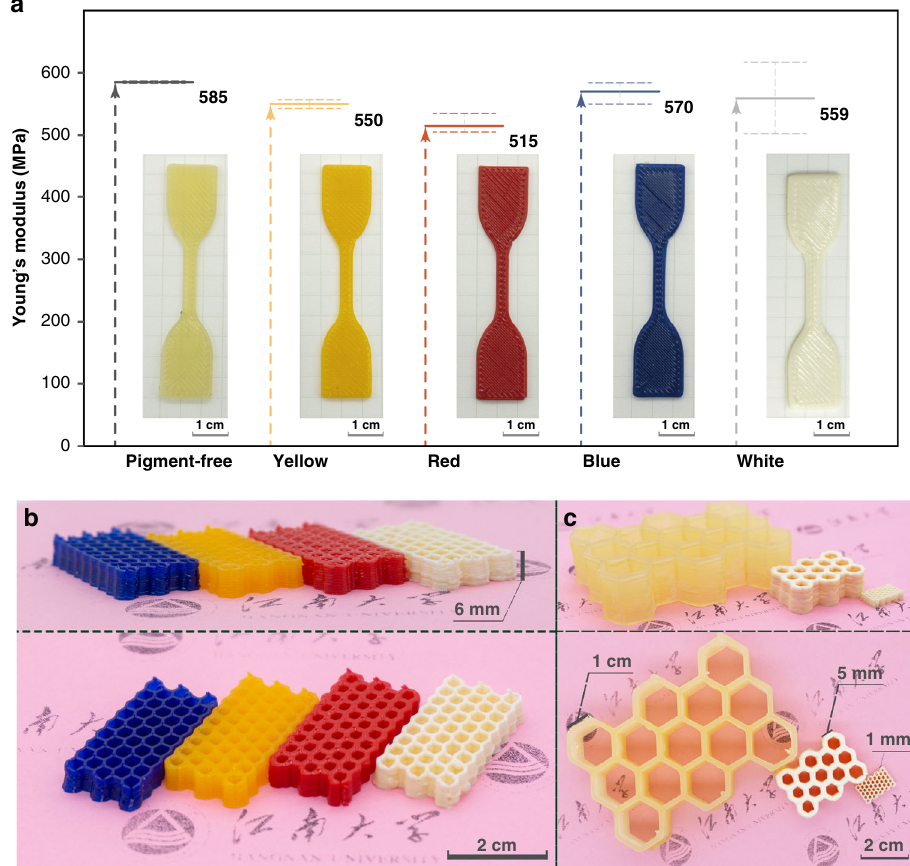
Fig. 5 NIR-DIW-printed objects with different colors and resolution. a Young ’ s modulus obtained by tensile test of 3D-printed samples, and error bars are reported as standard error of mean, and the scale bar is equivalent to 1 cm; b side view and top view of same structure printed by different pigments; c side view and top view of 3D-printed monolith structures in different resolution, the scale bar is equivalent to 2